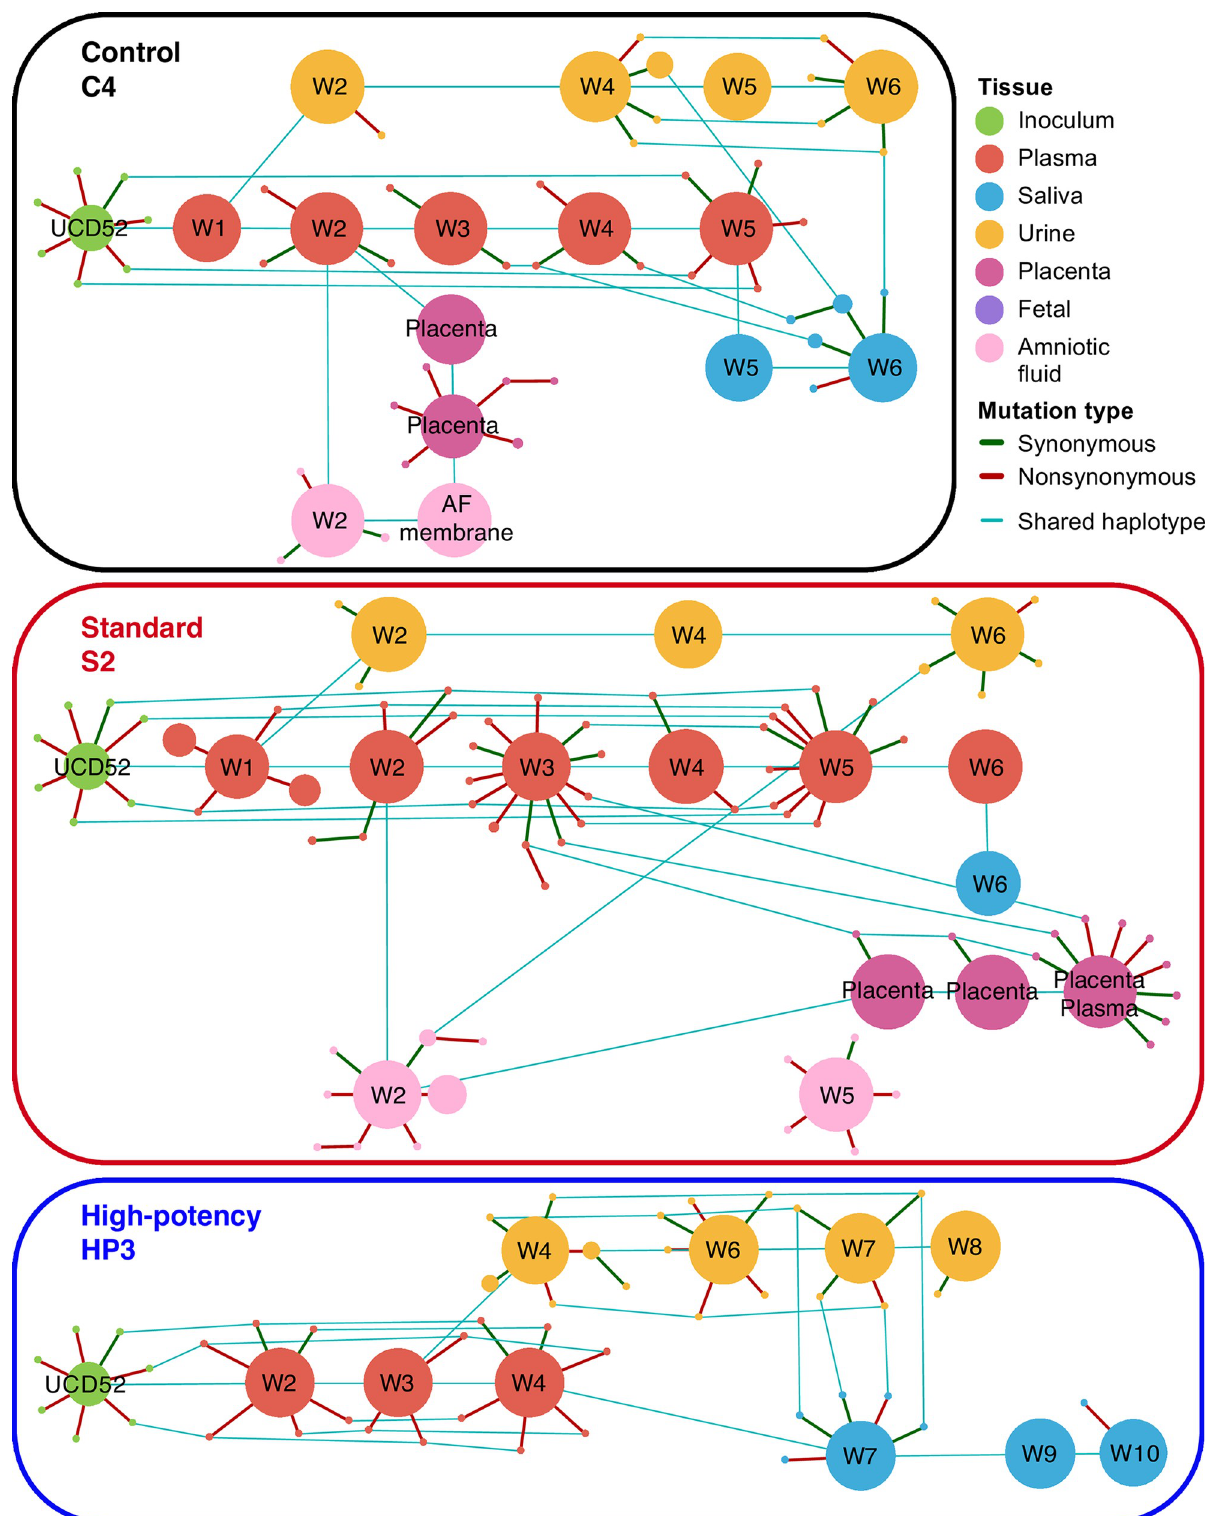
Fig 1. UCD52 haplotype networks for the gB locus across sampled tissues from three representative monkeys. Haplotype networks are shown for one control group dam (C4), one standard pretreatment group dam (S2), and one high-potency pretreatment group dam (HP3). Unique haplotypes